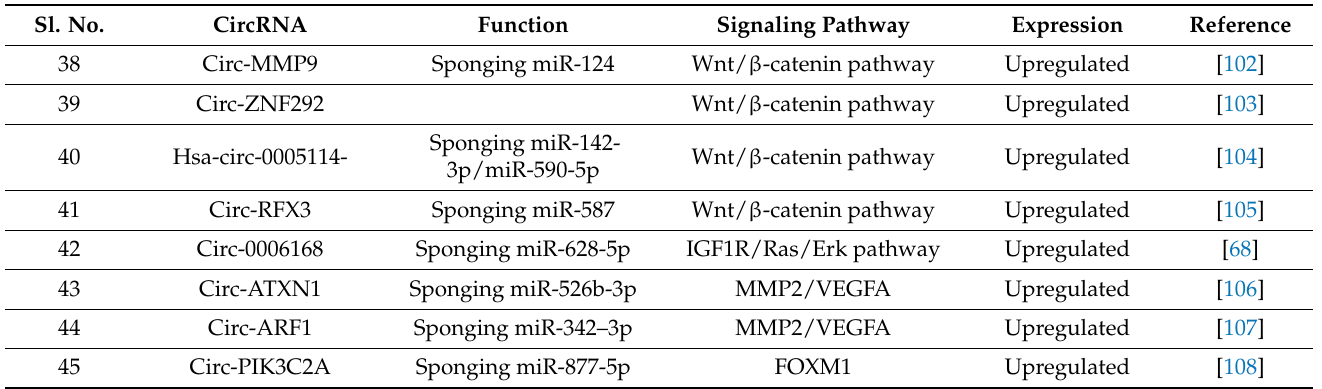
5.2. Circ-RNAs Responsible for the Down-Regulation of Glioblastoma